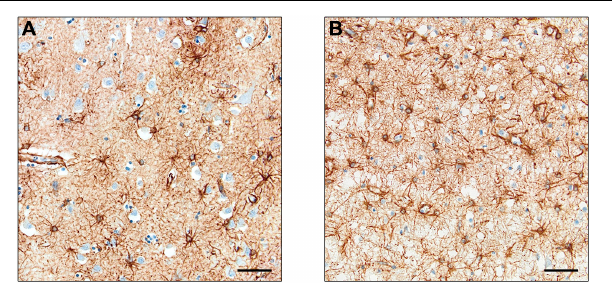
FIGURE 3 | Expression of GFAP+ astrocytes. Astrocytes in control cases (A) and Pick’s disease cases (B) , with the latter showing darker staining and greater cell number. Scale bars = 50 µ